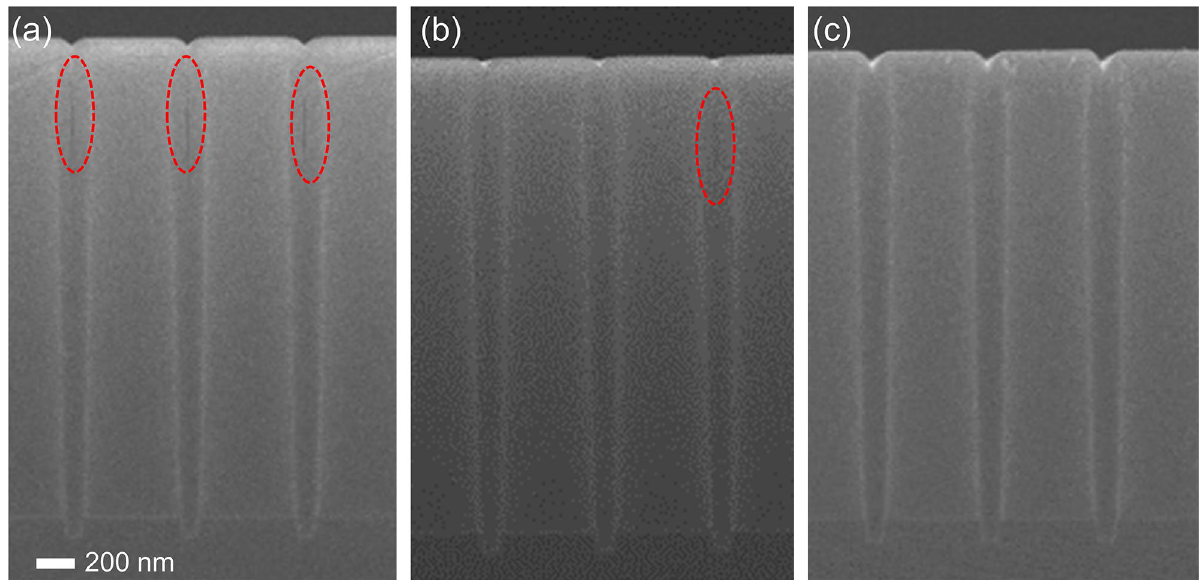
Figure 4. Cross-sectional field-emission scanning electron microscopy (FE-SEM) images of the trench pattern (aspect ratio of 25:1 with an opening size and a depth of 200 nm and 2.5 μm, respectively) after conducting SiO 2 PE-ALD with ( a ) no inhibitor, ( b ) N 2 * , and ( c ) NH 3 *